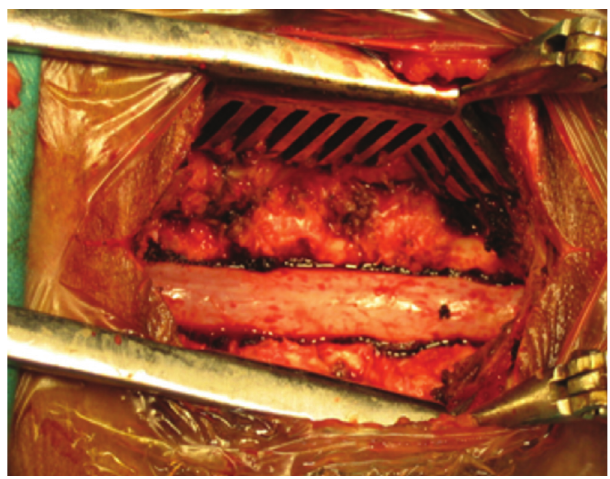
Figure 4. Lax dura seen after decompressive